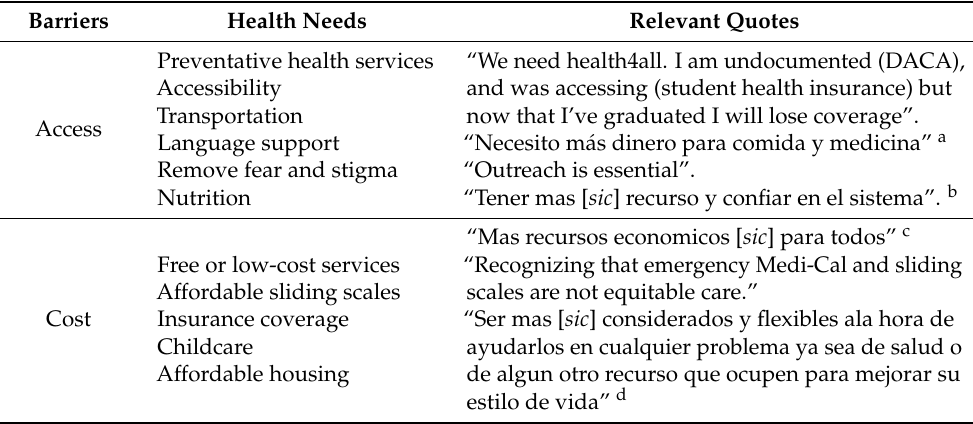
Table 4. Thematic Analysis of Open-Ended Responses on Barriers to Mental Health